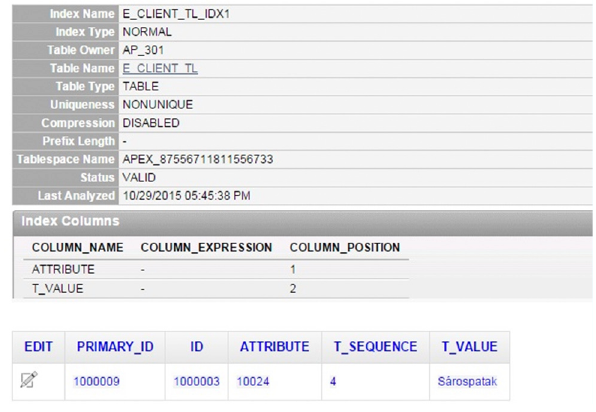
Figure 8. Indexing a record.